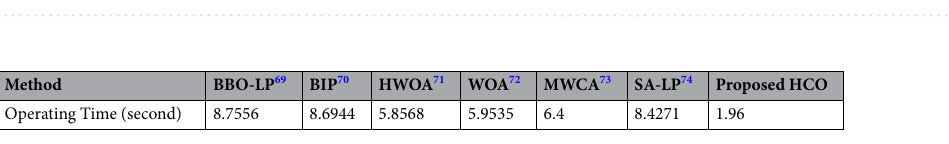
Table 9. Comparison of operating time for IEEE 8 bus distribution system.